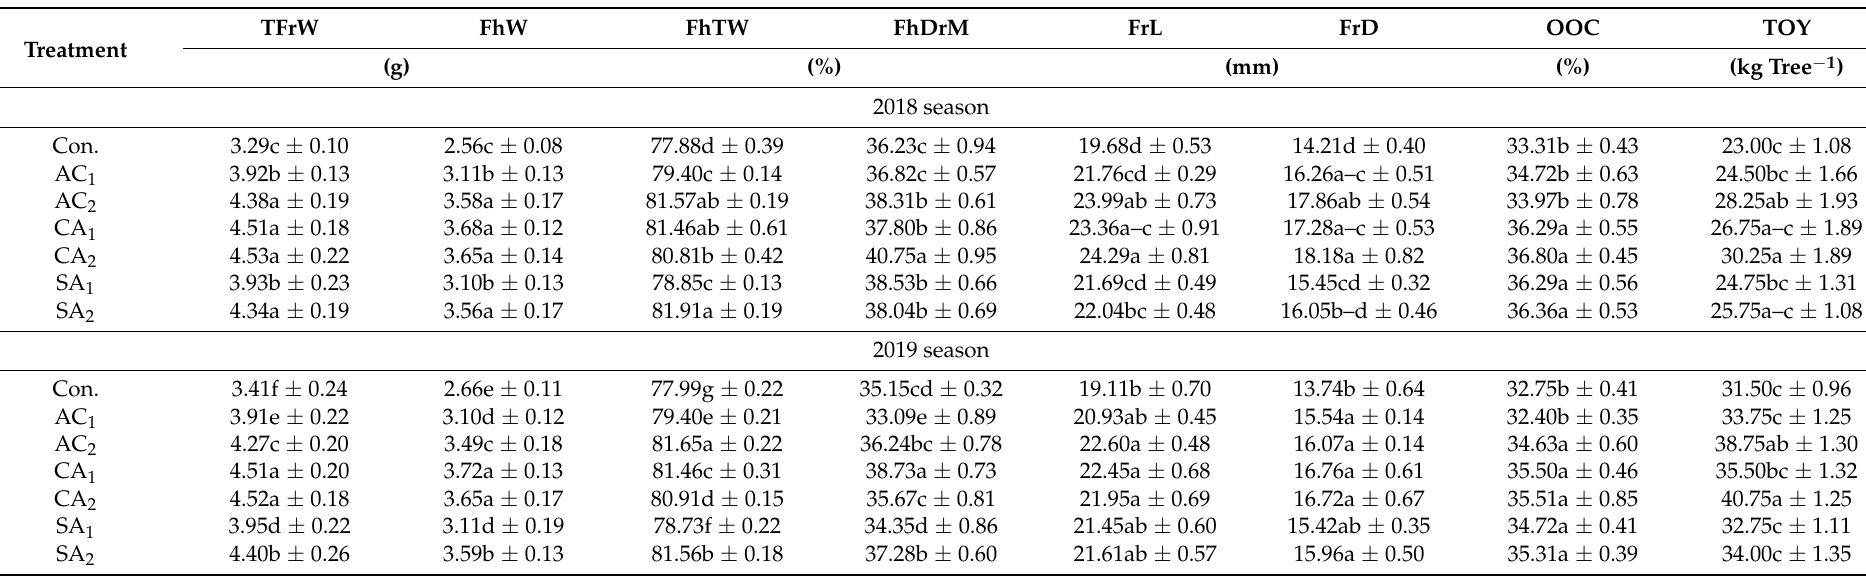
Table 6. Effect of acidifying agents as a soil application on fruit parameters, oil content, and total yield of olive trees (Picual cv.) grown in a sandy loam clay